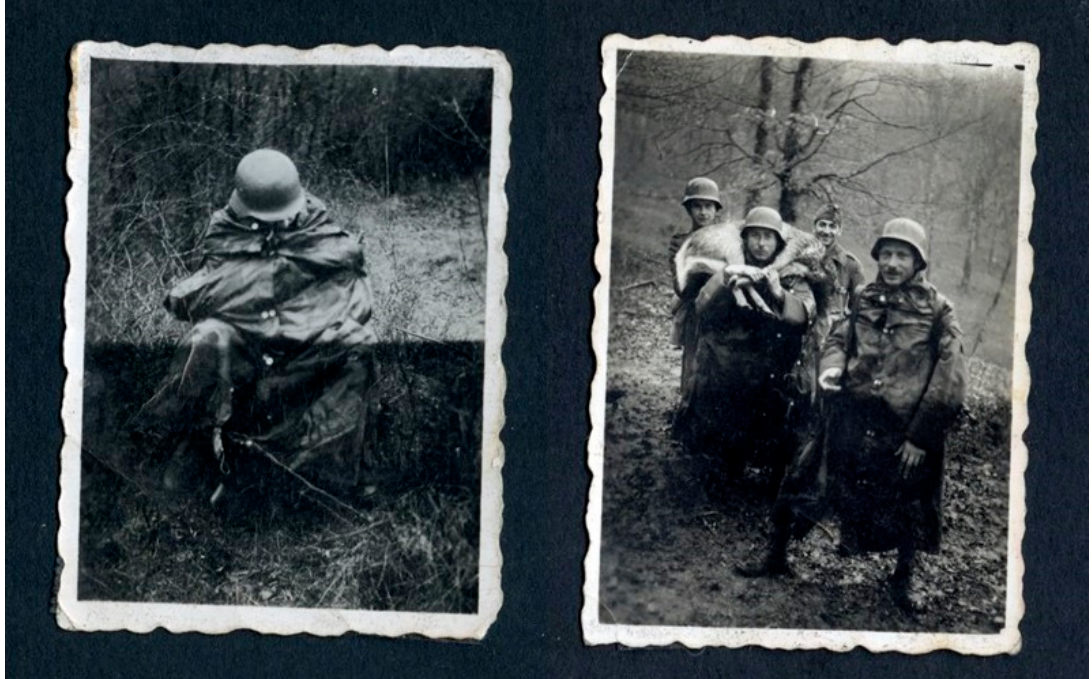
Figure 3. Katin’s father in the Army. Courtesy of the Katin Family Archive. Reproduced by permission of Miriam Katin.